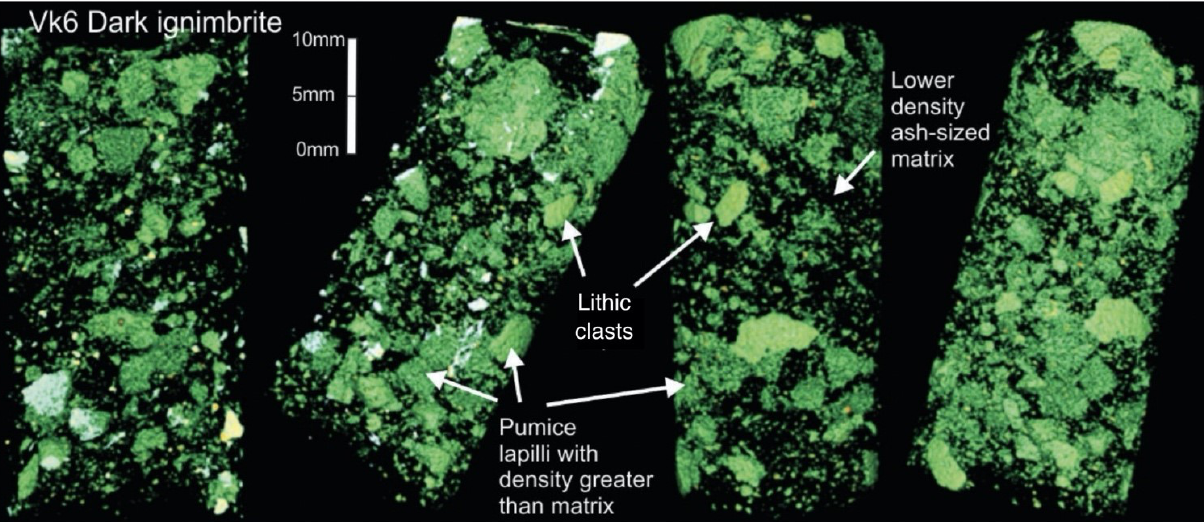
Figure 6: X-ray computed tomographic images showing shapes of lithic clasts and pumices in 3D (shown in green) on the sample scale of the dark ignimbrite (same sample rotated by 90 ° through each subsequent image). The lapilli and coarse ash show no obvious alignment in any of the samples. Here, we show the dark welded ignimbrite (VK6) with no strong alignment of the larger clasts despite the microscopic flattened textures locally seen in the glass shards of the thin